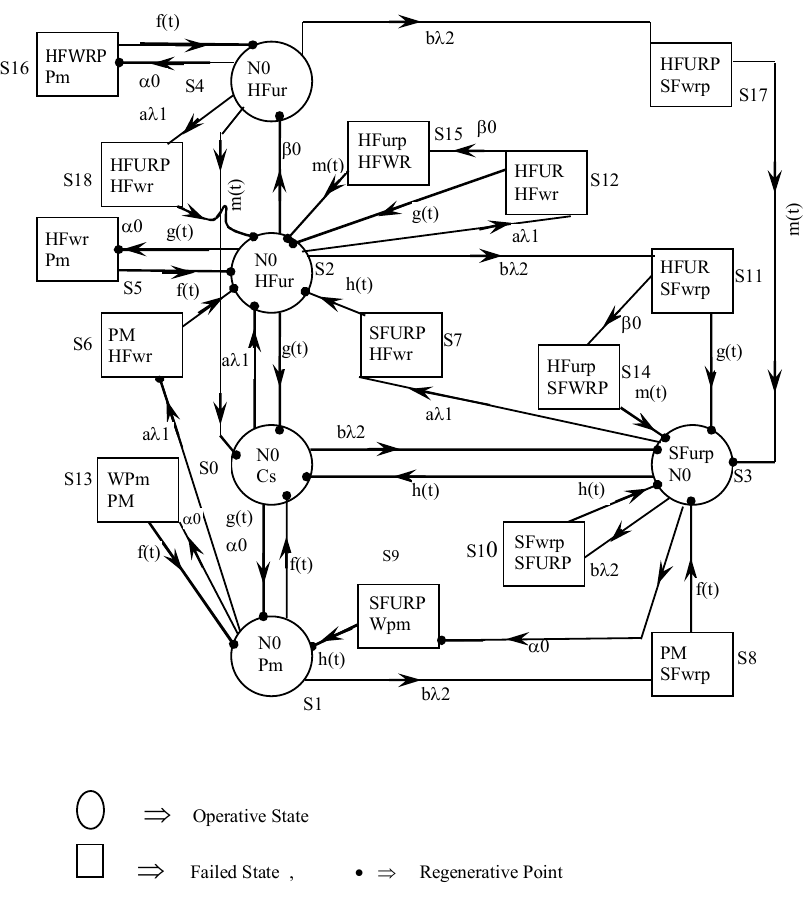
Fig. 1. State Transition